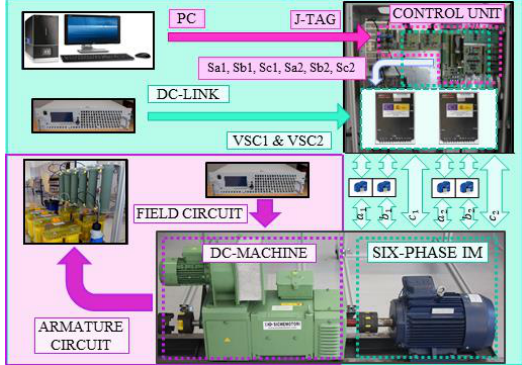
Figure 5. EVV-MPC scheme for six-phase induction motor drives.